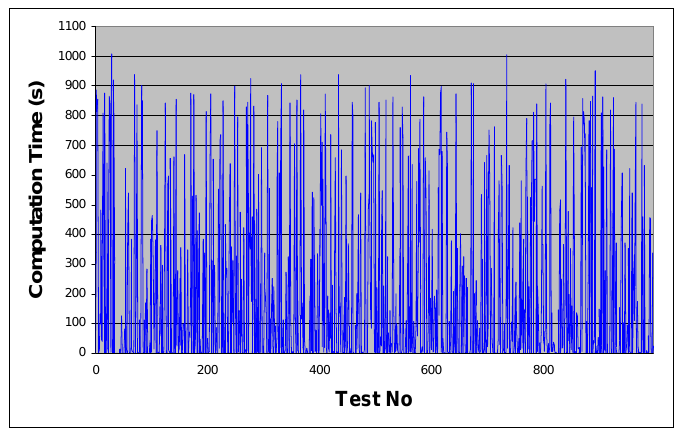
Figure 9. Hyperperiod simulation performance.